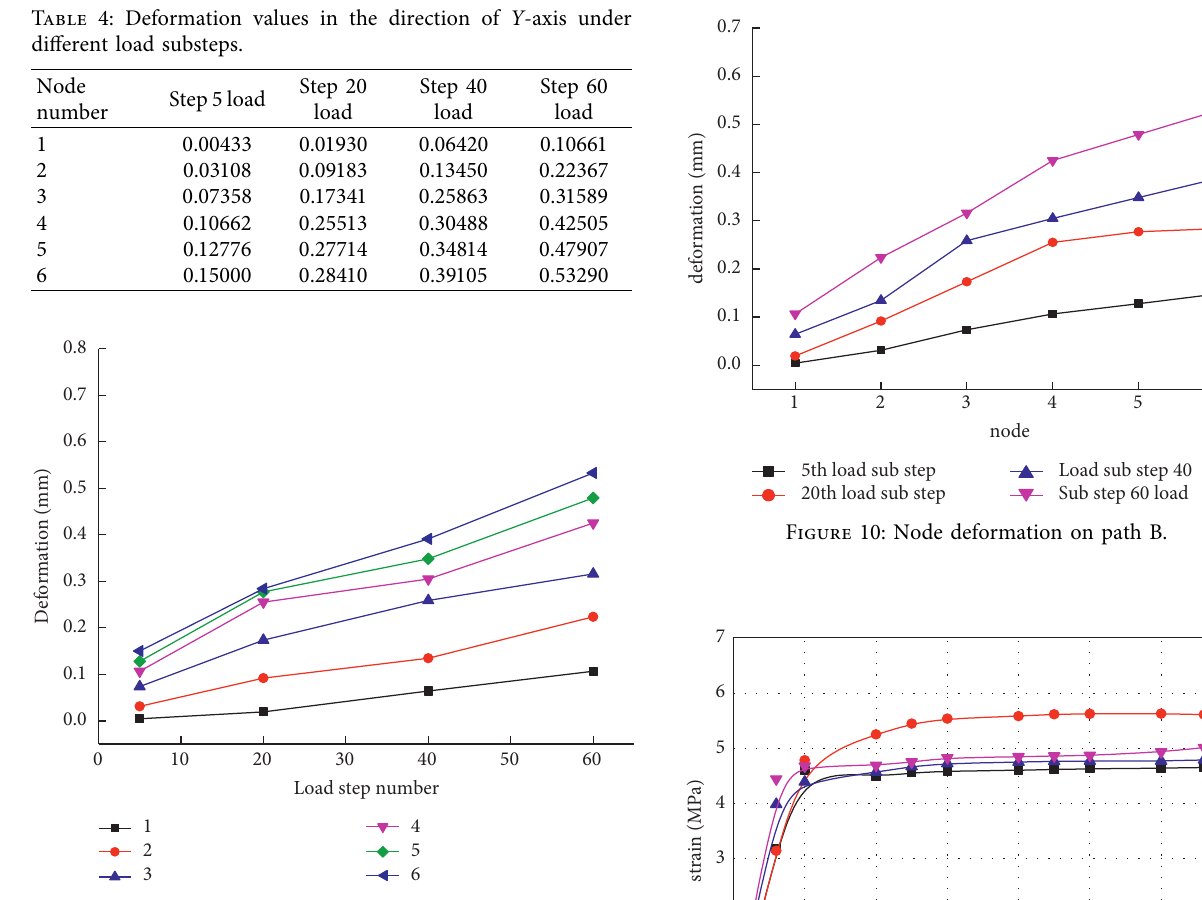
Figure 9: Node deformation on path A.